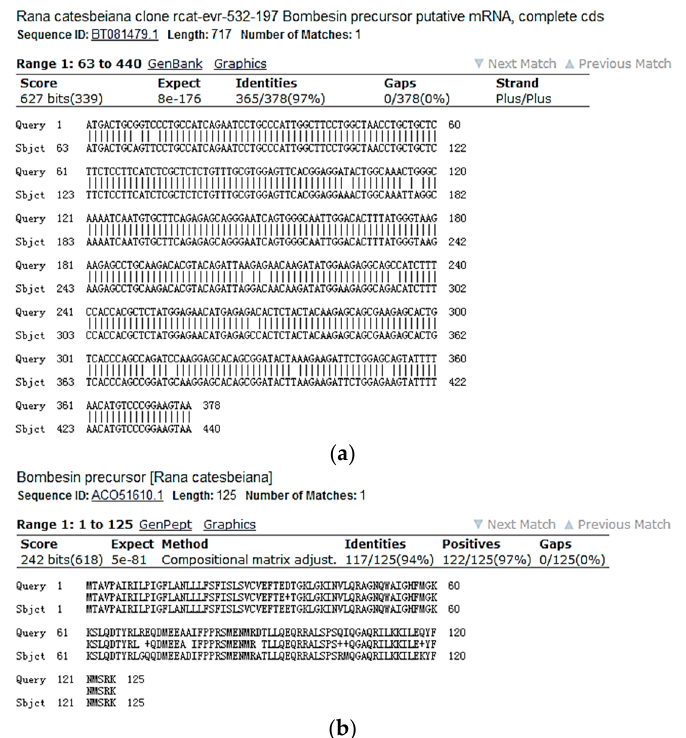
Figure 5. NCBI-BLAST analysis of the open-reading frame nucleotide and amino acid sequences of the ranatensin-HL biosynthetic precursor. ( a ) Ranatensin-HL ORF nucleotides 1–378 and bombesin precursor mRNA ( Rana catesbeiana ) nucleotides 63–440 showing 97% identity. (Accession number: BT081479.1); ( b ) Ranatensin-HL ORF amino acid 1–125 and bombesin precursor ( Rana catesbeiana ) amino acid 1–125 showing 94% identity. (Accession number: ACO51610.1).